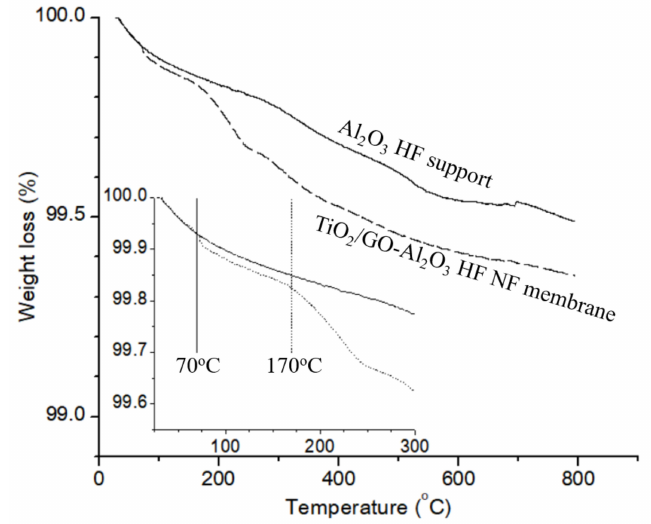
Figure 5. TG curves of the Al 2 O 3 HF support and TiO 2 /GO-Al 2 O 3 HF NF membrane. Inset: Initial weight loss (%) values (25–300 ◦ C).